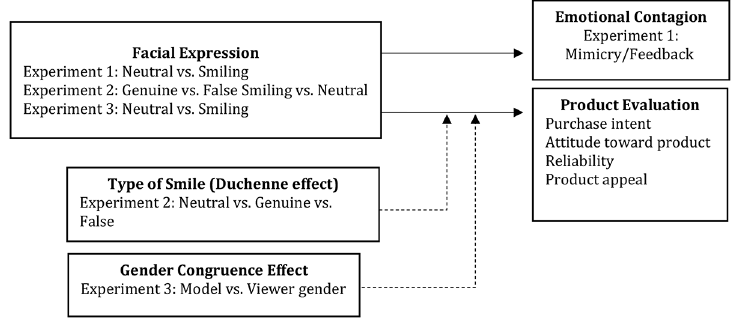
Figure 1. Proposed theoretical